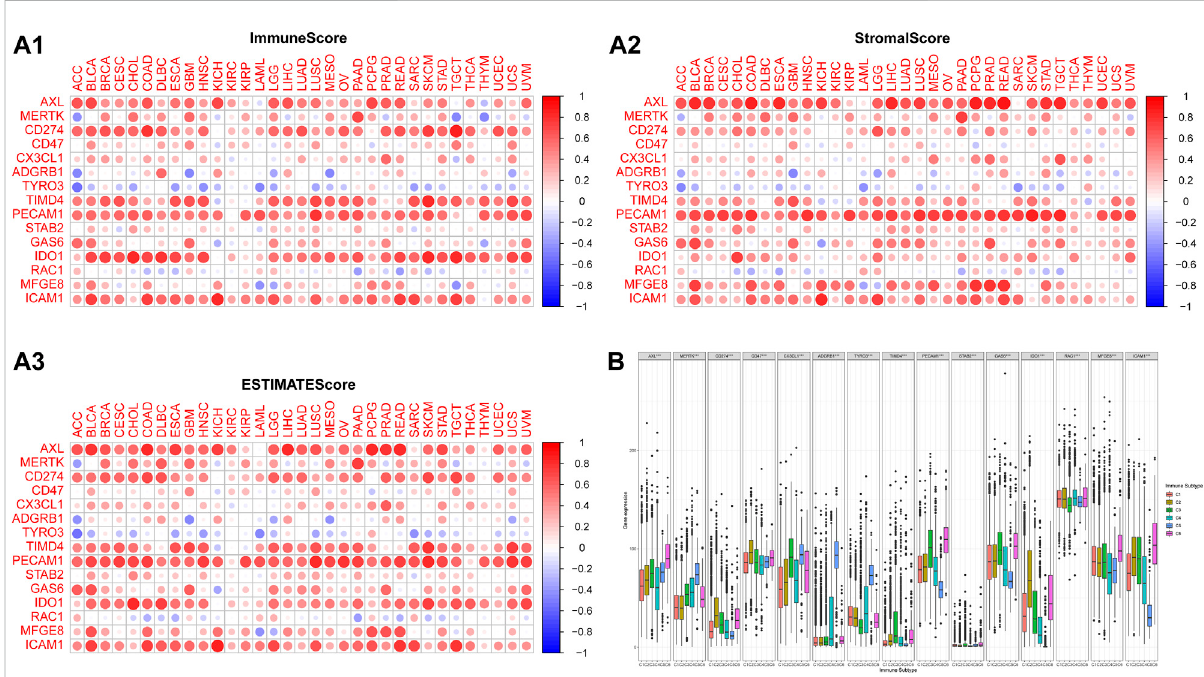
FIGURE 4 Thecorrelationsoftheexpressions ofefferocytosis-relatedmoleculeswiththemicroenvironment andimmune subtypein33typesofcancers. The corrplot package was used to assess the association of molecules with the immune score, stromal score, and ESTIMATE score. The color of a node re fl ects the log(FC) value of the Z score of gene expression, and the size of the node indicates the number of interacting proteins with the designatedprotein. (A1) Thecorrelationsoftheexpressionsofefferocytosis-relatedmoleculeswiththeimmunescore. (A2) Thecorrelations of the expressions of efferocytosis-related molecules with the stromal score. (A3) The correlations of the expressions of